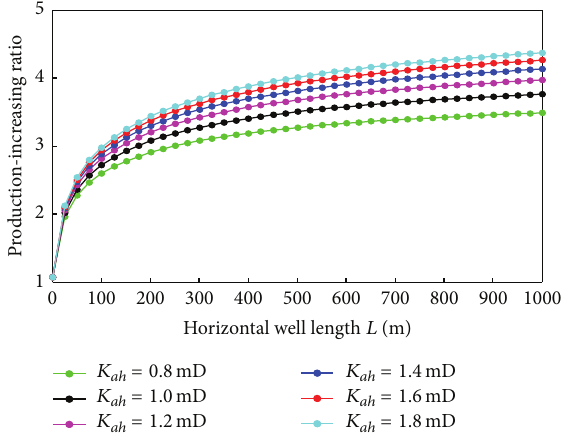
Figure 12: Effect of AZ’s permeability ( 𝐾 𝑎ℎ ) on production- increasing ratio ( 𝐿 = 1000 m, 𝑟 𝑤 = 0.1 m, 𝜀 = 0.00016 m, 𝛾 𝑔 = 0.56 , = 0.023 mPa ⋅ s, 𝑍 = 0.9 , 𝑇 = 366 K, ℎ = 10 m, 𝑝 = 20 MPa, 𝜇 𝑔 𝑤𝑓 = 0.6 mD, 𝐾 = 0.1 mD, 𝐾 = 0.1 mD, 𝑑 = 1.6 m, 𝐾 ℎ V 𝑑ℎ V . max = 0.2 m, 𝑎 = 1.2 m, and 𝑎 = 0.15 m). 𝑑 V . min V . max V . min